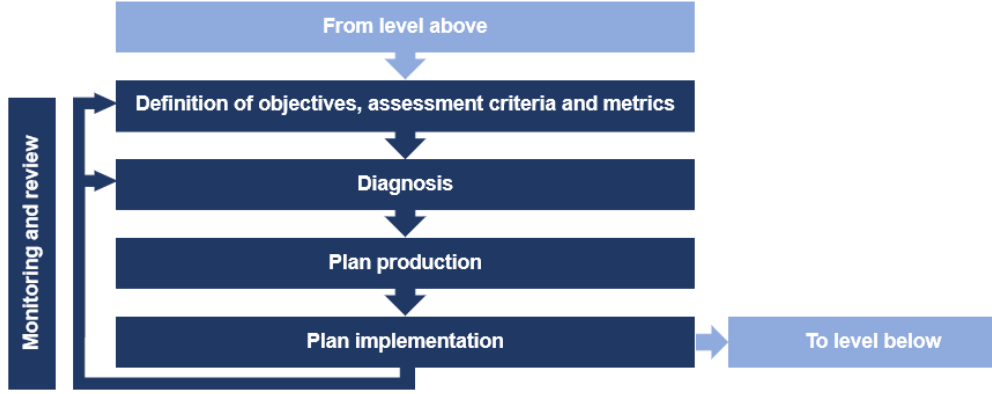
Figure 1: The AWARE-P’s IAM planning process [1].